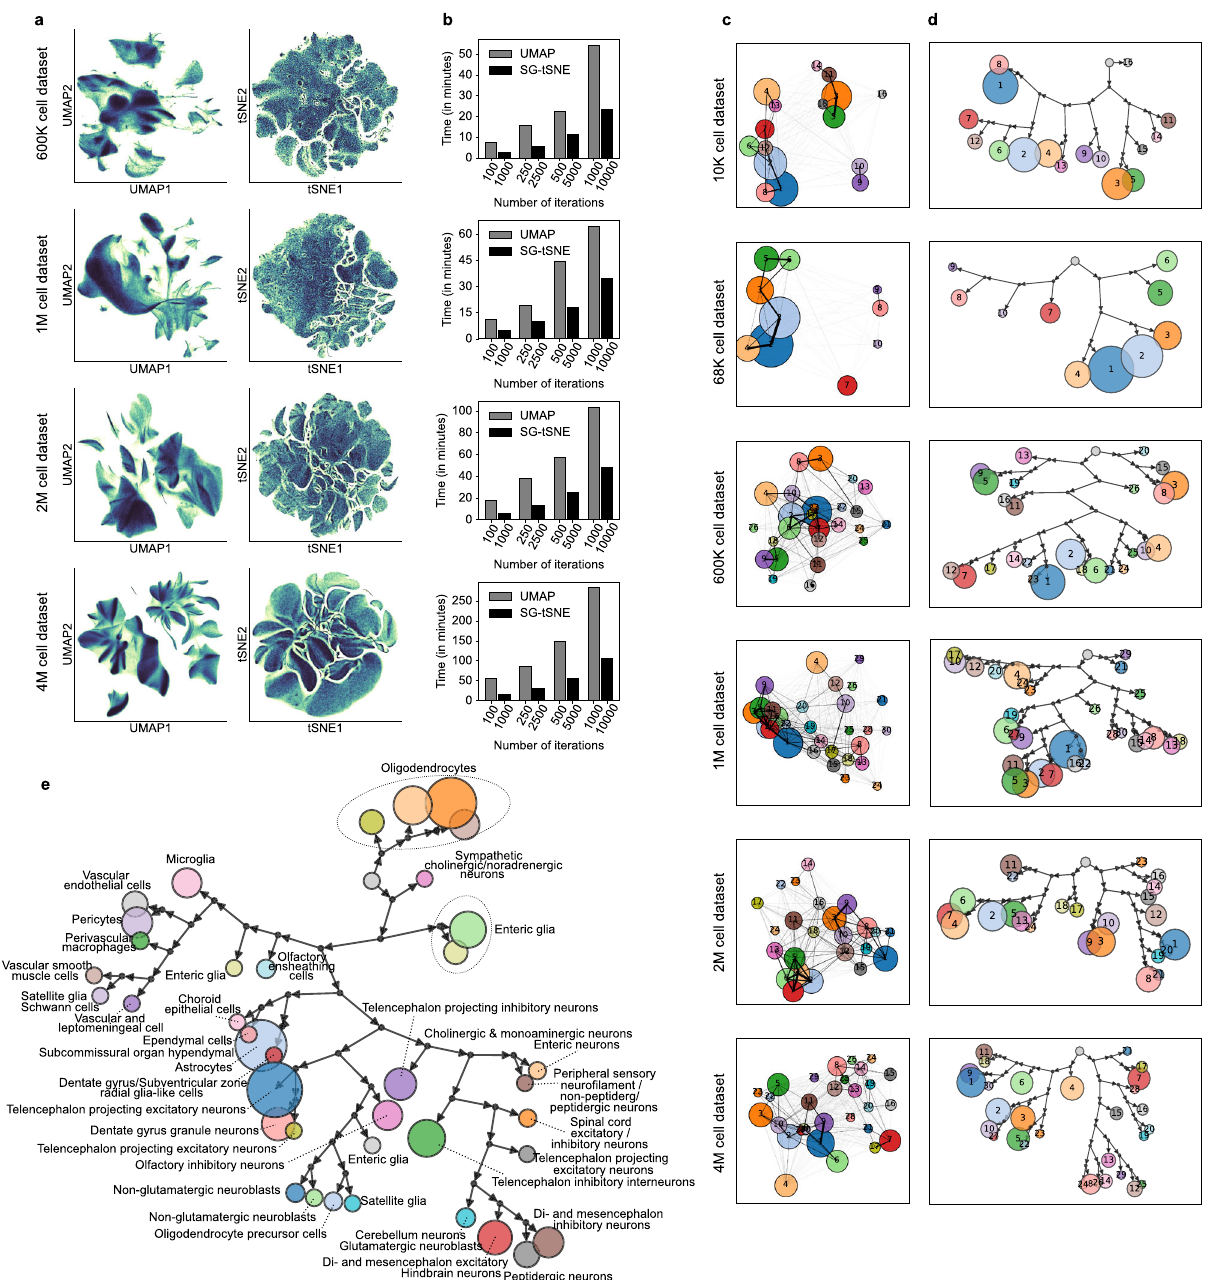
Fig.7|SG-tSNEandParishierarchicalclusteringonsingle-celldatasets.a UMAP and SG-tSNE embeddings of the four, atlas scale single-cell RNA-Seq datasets. The colour gradient shows regions of high (darker regions, with black at the extreme) andlowcelldensity(lighterregionswithlightyellowattheextreme). b Runtime(in minutes) of UMAP and SG-tSNE at a different number of iterations, on Scarf com- puted cell-cell neighbourhood graph. c Scatter plots, for each dataset, show cen- troids of each Paris cluster in UMAP space. The lines connecting pairs of cluster centroids indicate the weighted sum of edges (in the cell-cell neighbour graph) sharedbythoseclusters.Thickerlinesindicatealargerdegreeofsimilaritybetween the clusters. The number on cluster centroids indicate cluster ID. d Paris